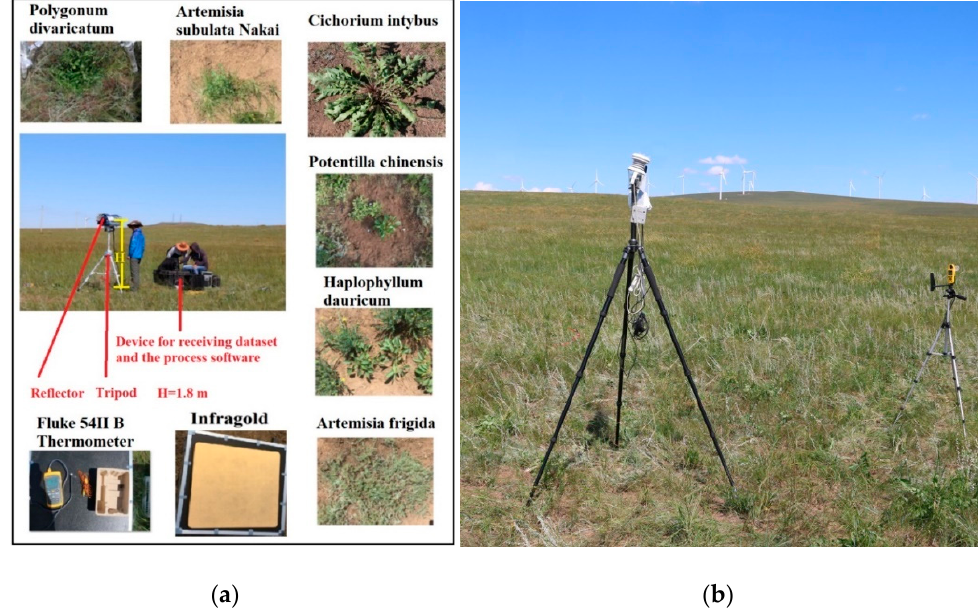
Figure 4. The experiments: ( a ) is the observation experiments of different types of vegetation, ( b ) is a simple meteorological station instrument for collecting the local climate data.